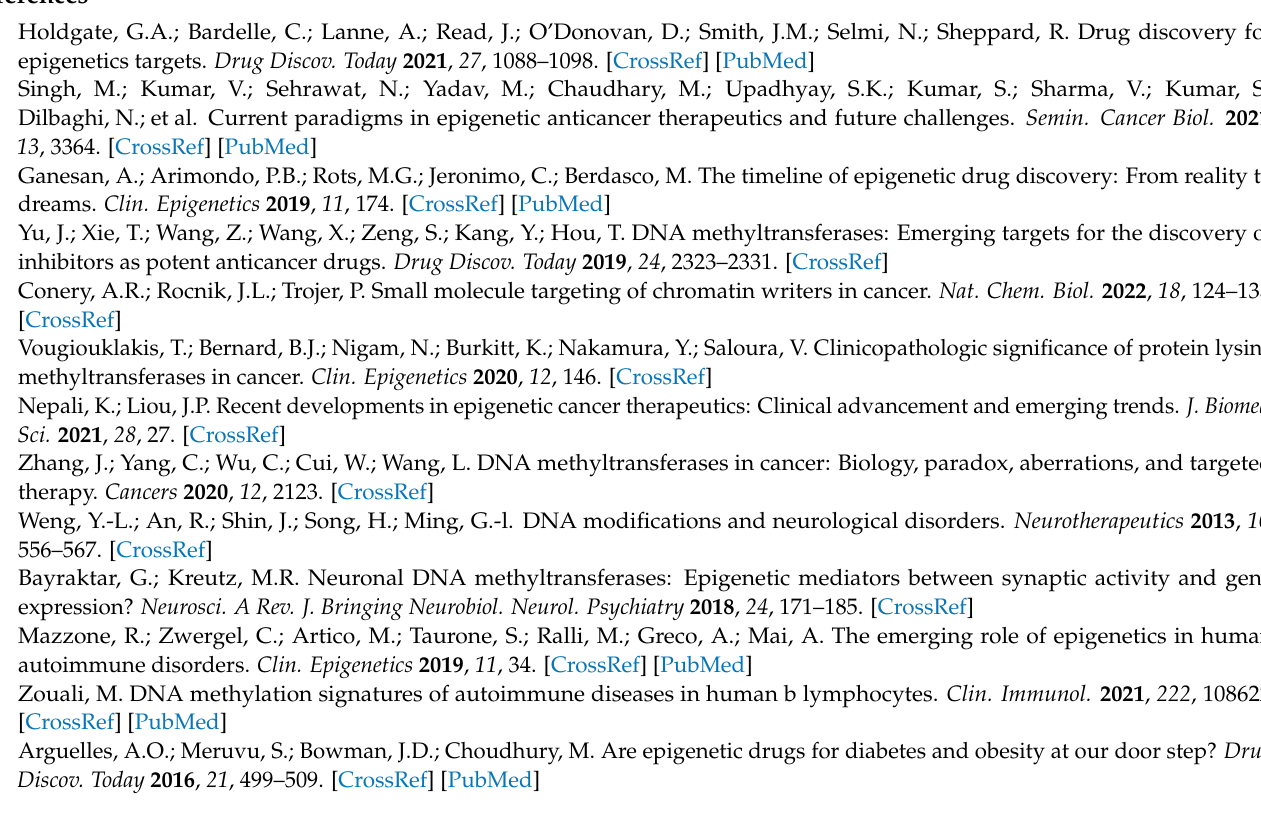
Figure S2: Final conformational changes on DNMT1 from molecular dynamics calculations; Figure S3: In silico profiling of the three compounds with the free online and validate server Epigenetic Target